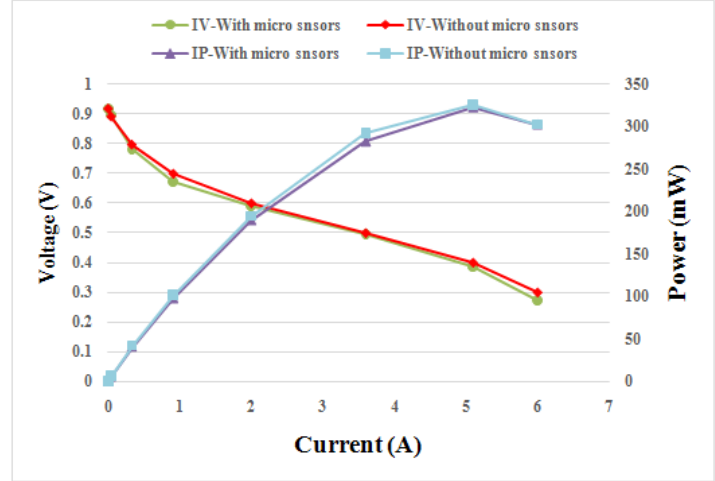
Figure 9. Comparison between performances of cells with and without embedded flexible integrated microsensor. Table 2. Reaction area and maximum power of cells with and without embedded flexible integrated microsensor.